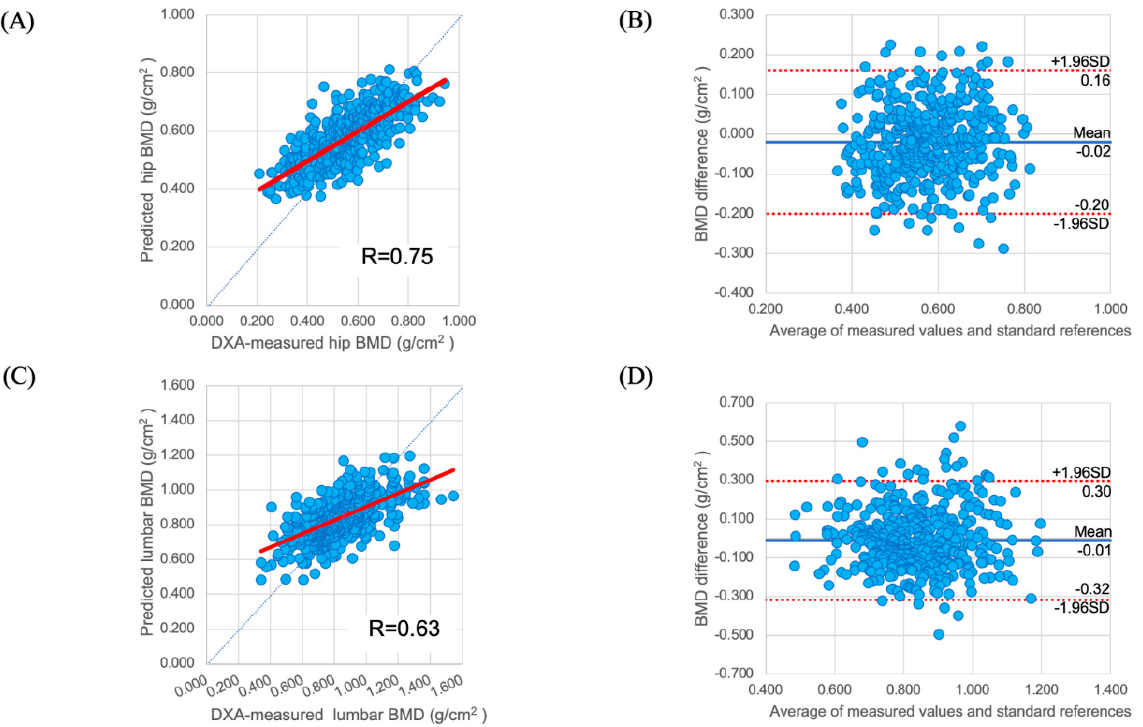
Figure 2. Predictive performance of regression on BMD. ( A ) Linear fitting curve and ( B ) Bland-Altman plot for the trained model for femoral BMD prediction. ( C ) Linear fitting curve and ( D ) Bland-Altman plot for the trained model for lumbar spine BMD prediction. Model predictions were compared with the ground truth. In the linear fitting curve, R is the Pearson correlation coefficient. Each point in the Bland-Altman plot represents a pair of DXA BMD and predicted BMD; the horizontal axis depicts the mean, whereas the vertical axis depicts the difference. Note: BMD: bone mineral density; DXA: dual-energy X-ray absorptiometry; SD: standard deviation.